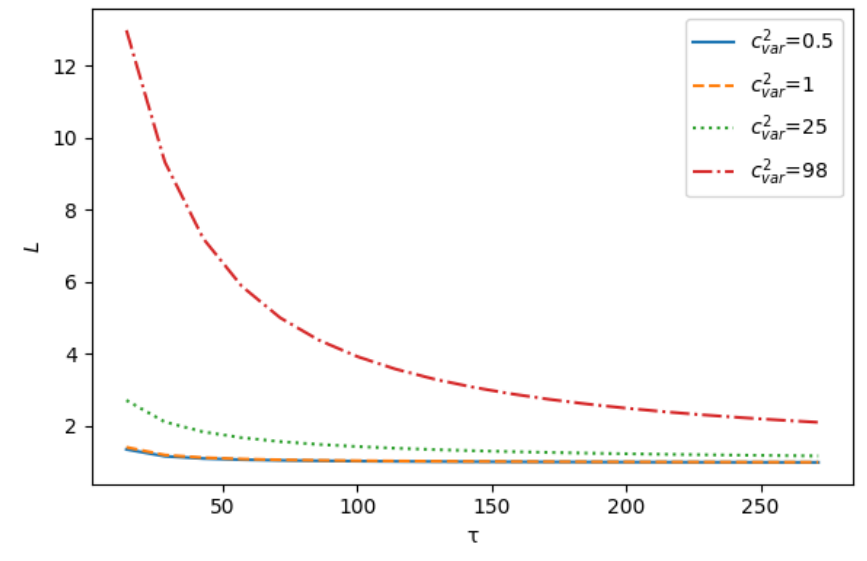
Figure 4. L vs. τ for the inter-retrial times with different coefficients of variation.